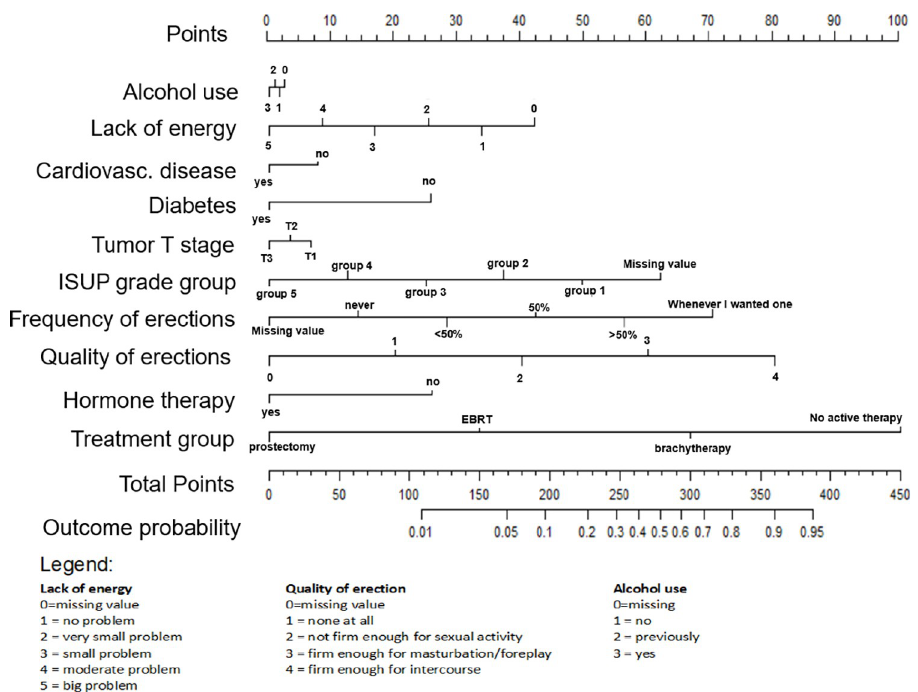
Fig 6. A nomogram of the 1-year erectile dysfunction model. Each predictor was given a score on a point scale representing its level of impact on ED development. The highest total score was 100 points for the treatment group, highlighting the importance of this variable. Meanwhile, equal scores for predictors like diabetes and hormone therapy in the 1-year nomogram, indicate the same influence of them on ED. The low score assigned to alcohol use after one year and hormone treatment after two years indicate a relatively small impact of these variables on